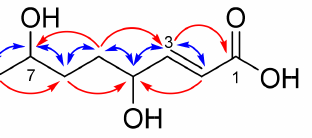
Figure 3. Selected COSY correlations (blue) and HMBC correlations (red) for 1